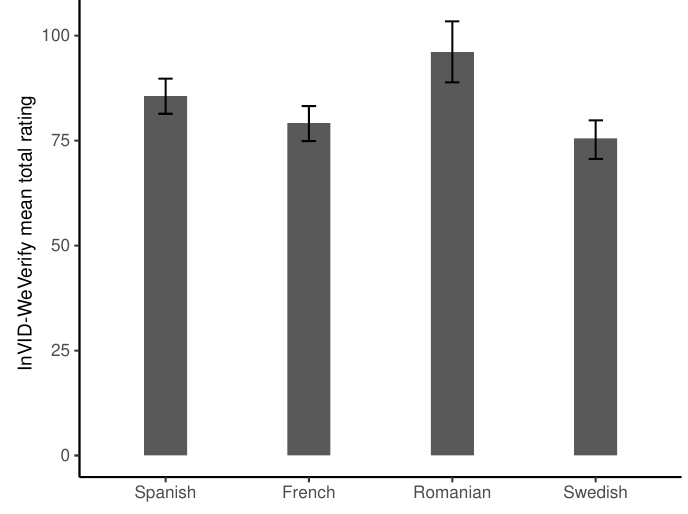
Figure 8. Mean total ratings on InVID-WeVerify attitudes ( y -axis) with standard error of mean (error bars) for each language ( x